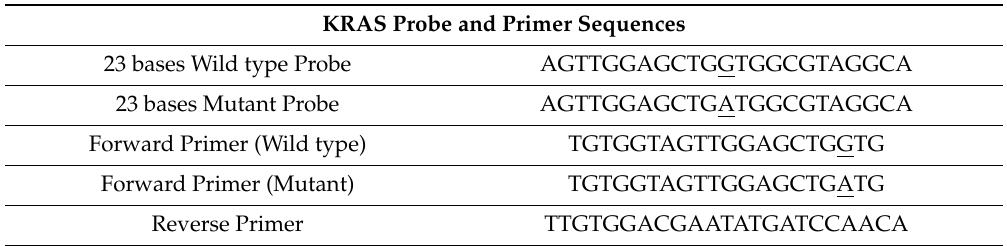
Table 1. List of DNA sequences employed in this